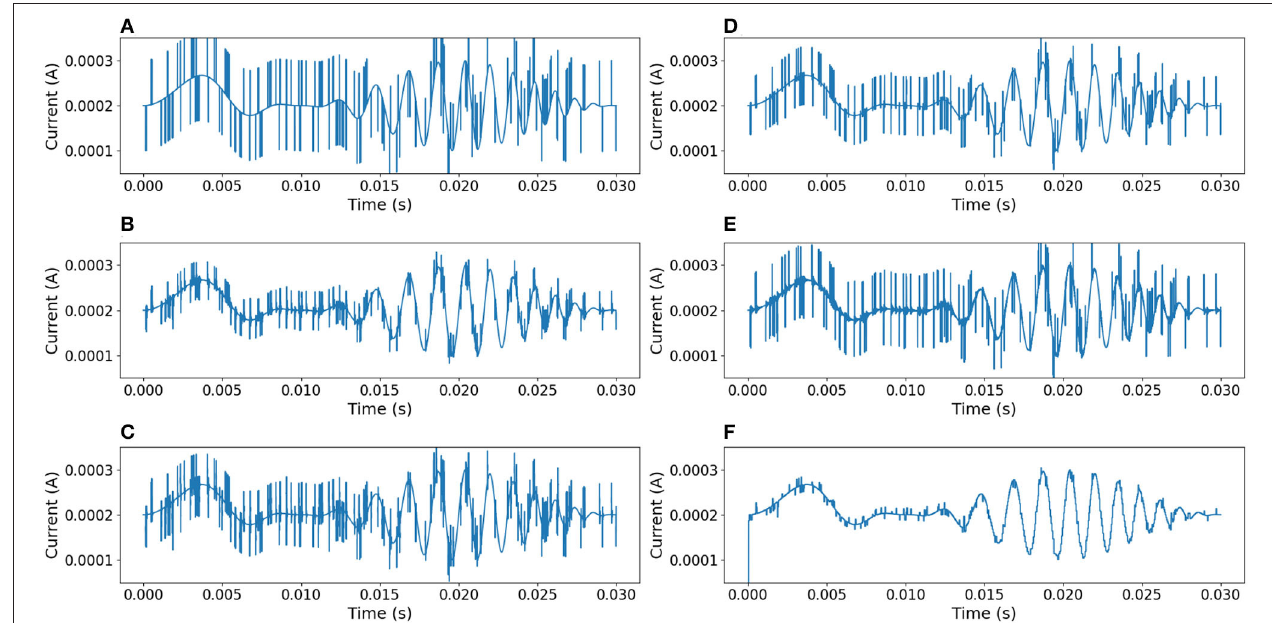
FIGURE 13 | Comparison of results between different filters. The signal is affected by impulsive random noise (random pulses of 5 µ s and 0.1 mA were added). (A) Median filter. (B) 3rd-order Chebyshev type 1 filter with cutoff frequency at 55 kHz . (C) 3rd-order Chebyshev type 2 filter with cutoff frequency at 55 kHz . (D) 3rd-order Butterworth filter with cutoff frequency at 55 kHz . (E) 3rd-order Elliptic filter with cutoff frequency at 55 kHz . (F) Neural filter proposed.